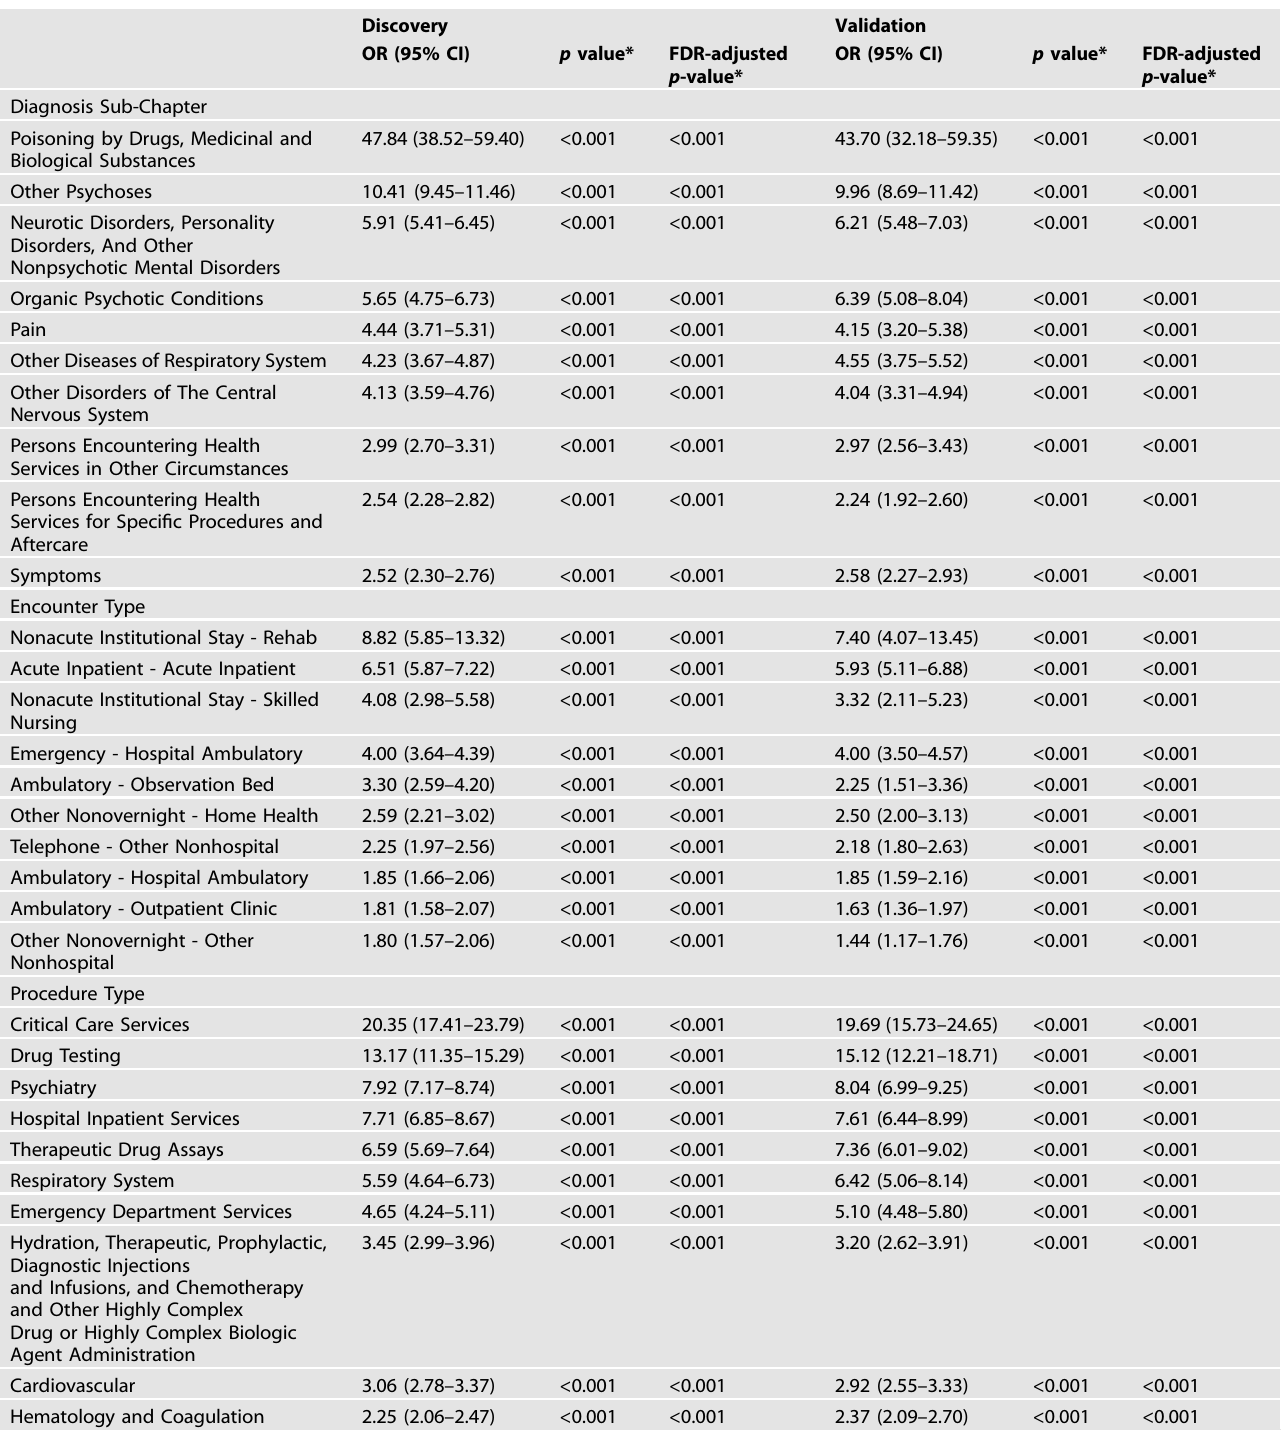
Table 2. Univariate odds ratios for death by suicide adjusted by age and